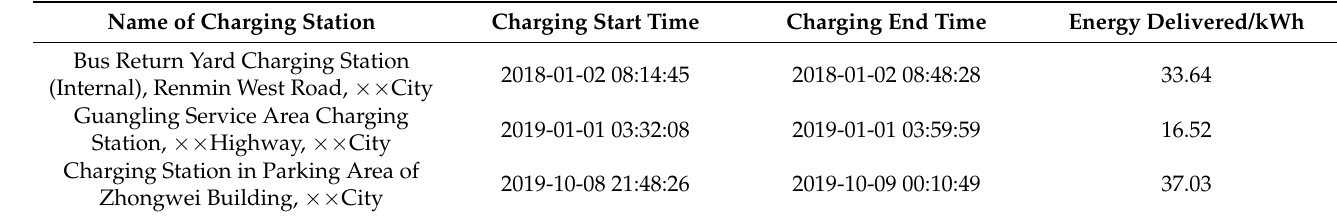
Table 1. Basic format of power supply side